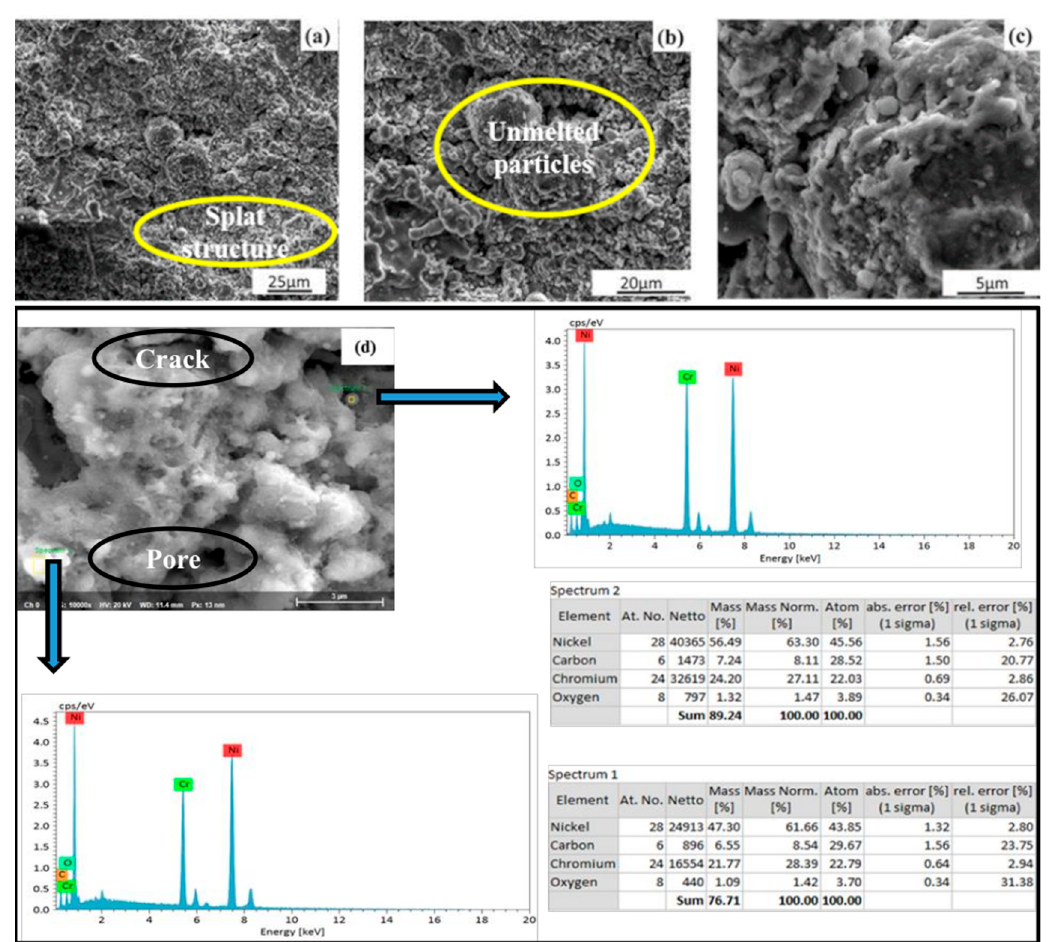
Figure 4. Surface morphology of the Cr 3 C 2 –25NiCr coating at: ( a ) Lower magnification, ( b ) intermediate magnification and ( c ) higher magnification; ( d ) Surface profile of the coating with EDS spectra.